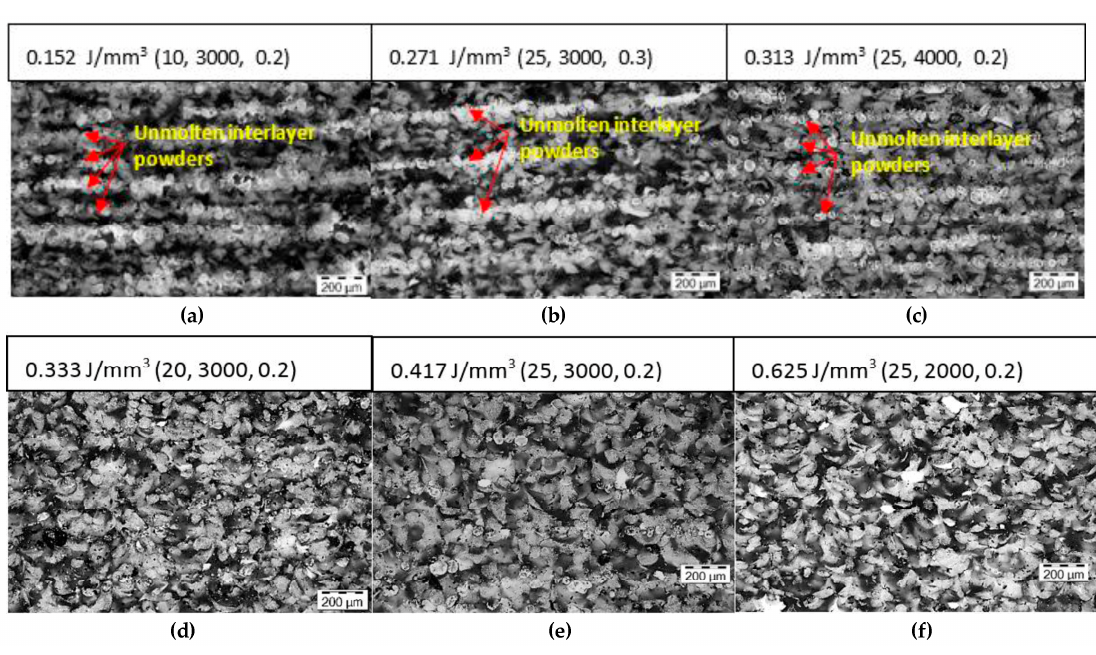
Figure 7. The microstructures of the CNTs/PA12 parts sintered upon varied laser input energy in the X – Z plane (power (W), scanning speed (mm/s), hatching space (mm)) ( a – f ).